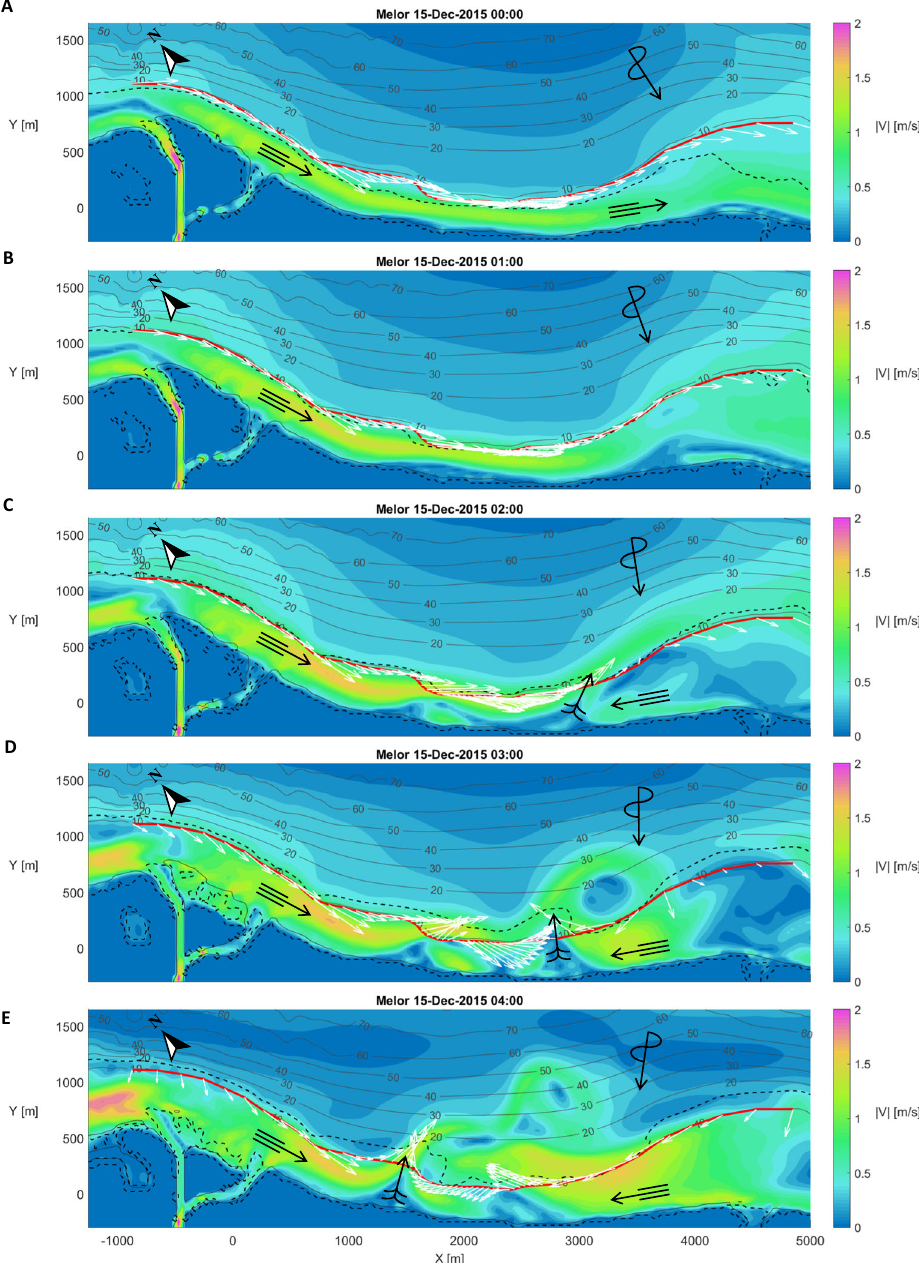
Fig. 6 Megarip current development across the Naujan embayment. Snapshots of simulated fl ow conditions during the peak of the storm induced by typhoon Melor on 15/12/2015 at a 00.00 b 01.00 c 02.00 d 03.00 e 04.00. Red line represents the onshore boundary of TCsolver. White arrows indicate extracted depth-averaged current directions to inform TCsolver. Dashed line is the contour of 1% breaking waves, representing the extension of the typhoon-induced